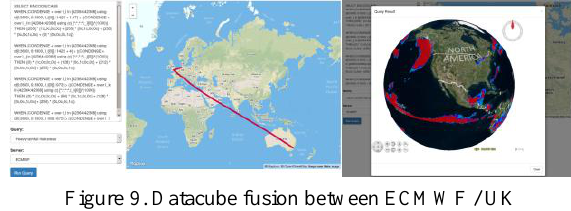
Figure 9. Datacube fusion between ECMWF / UK and NCI Australia: query distribution path (left) and result visualization (right) (source: